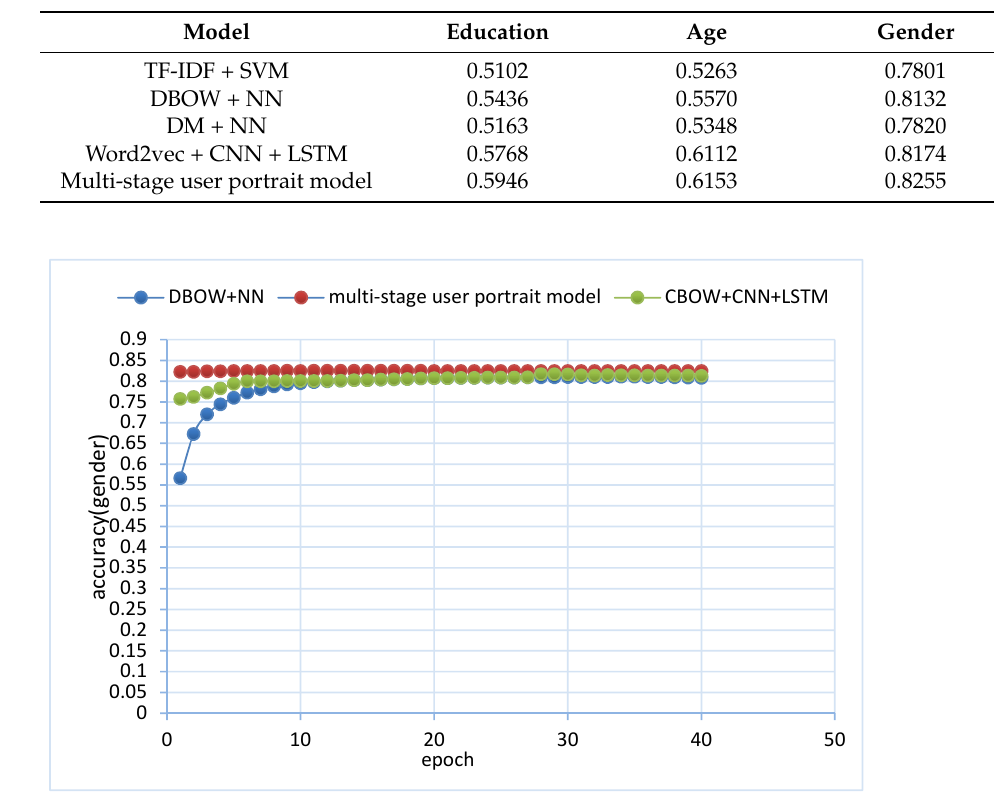
Table 6. Comparison of the prediction accuracy of the models.